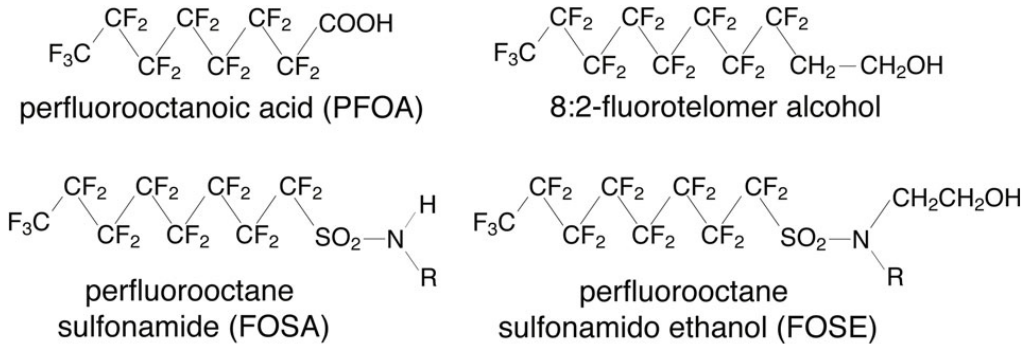
Fig. 2. Chemical structures of PFOA and selected precursor compounds. R: CH 3 , or CH 3 CH 2